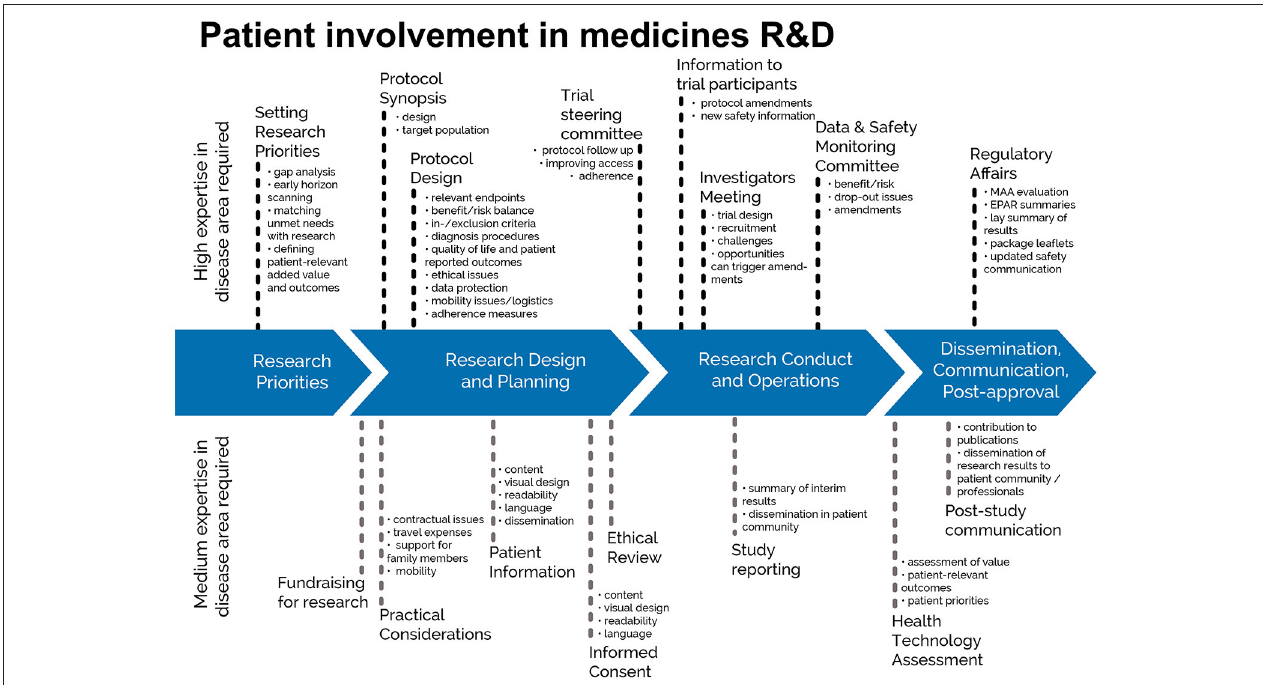
FIGURE 1 | Patient involvement in medicines R&D: Patients can meaningfully contribute across the process of medicines R&D. This diagram distinguishes between areas in the R&D process that require a high level or a medium level of expertise in the respective indication. © EUPATI, under a Creative Commons licence CC BY-NC-SA 4.0. Used with